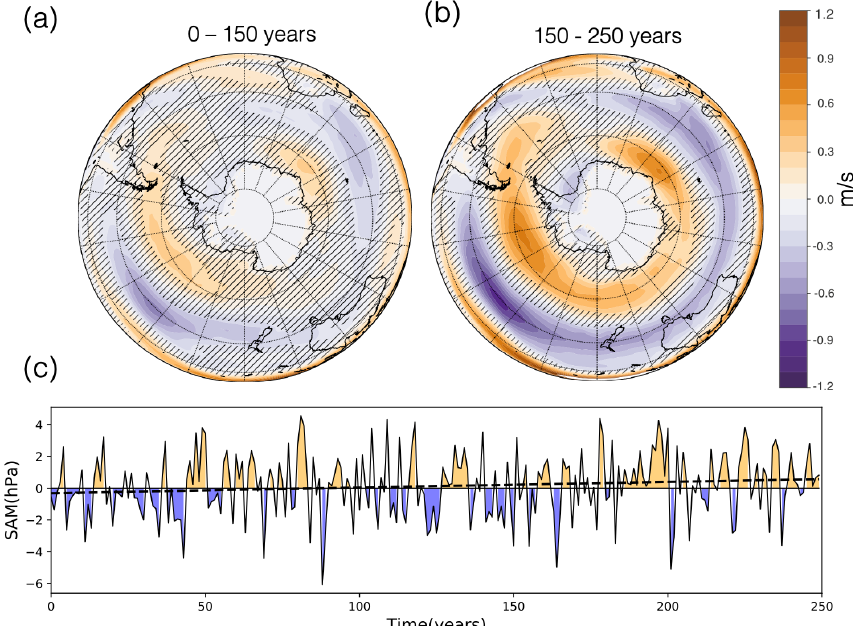
Figure 11. LIG_hosing–LIG anomalies for U at 850hPa computed over the first 150 years (a) and the last 100 years (b) of simulation. Non- hatched areas correspond to statistically significant differences (at 95% confidence). The annual SAM index for the LIG_hosing simulation is shown in (c) . The linear regression line (dashed) represents a statistically significant positive trend with a p value < 0.05.